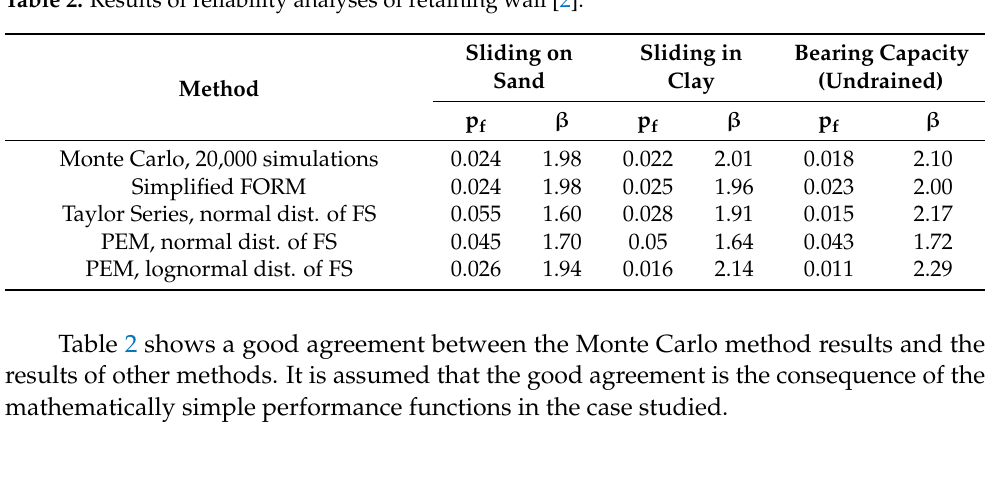
Table 2. Results of reliability analyses of retaining wall